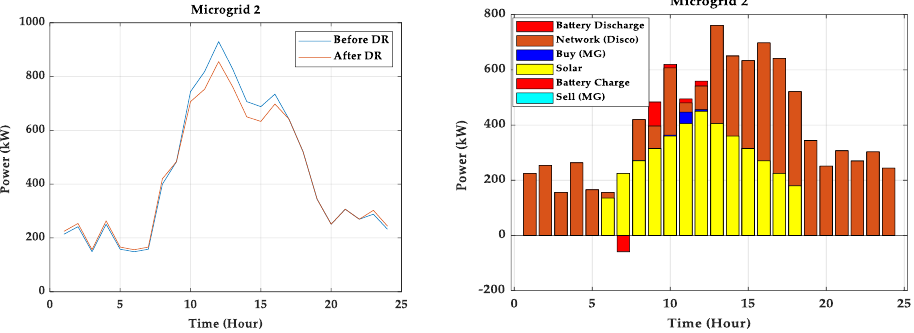
Figure 22. Impact of demand response on MG 1.